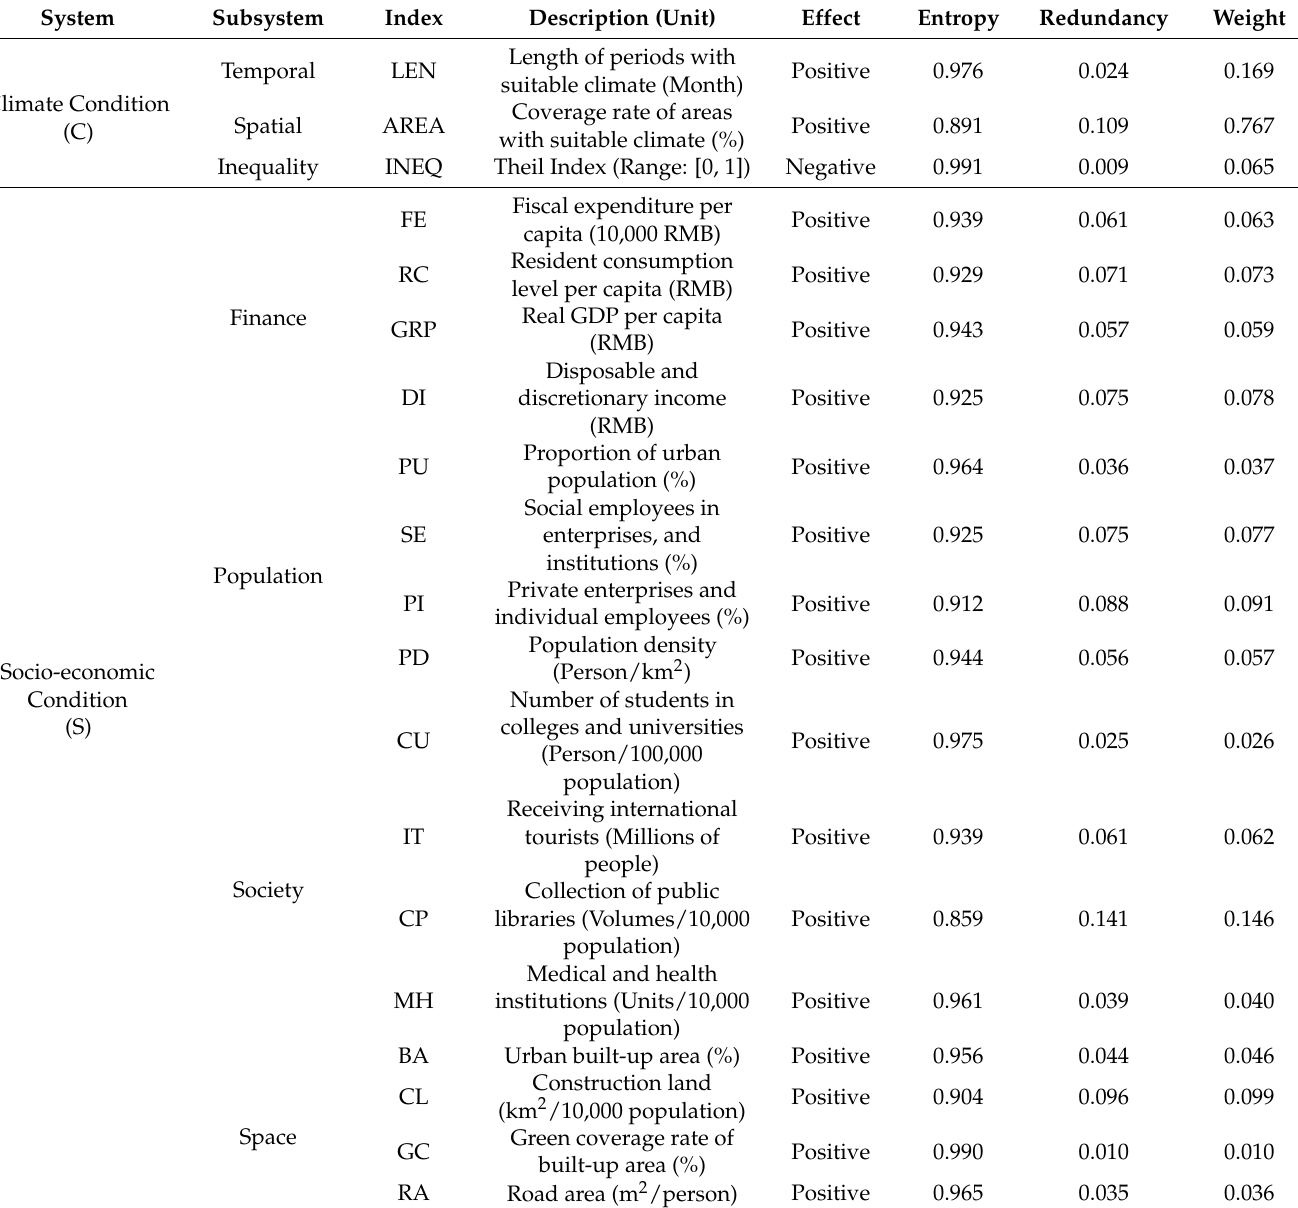
Table 1. Evaluation index systems of climate and socio-economic